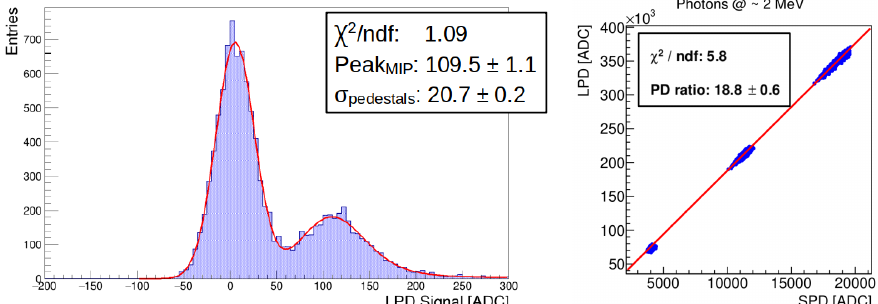
Figure 2. Left panel: MIP distribution of a LPD; the left peak is the pedestal peak while the one on the right is the MIP events peak. Right panel: correlation plot between LPD and SPD measured with a multiparticle beam of photons with a mean energy of 2